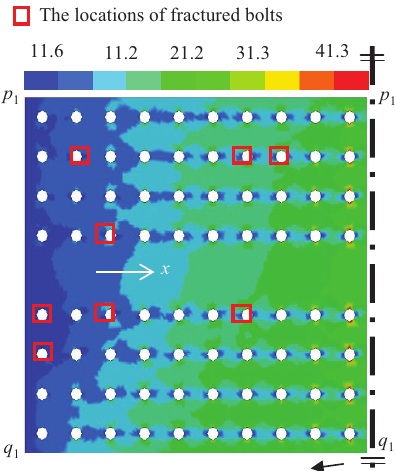
Figure 16. The x -axial stress in the splice plate L